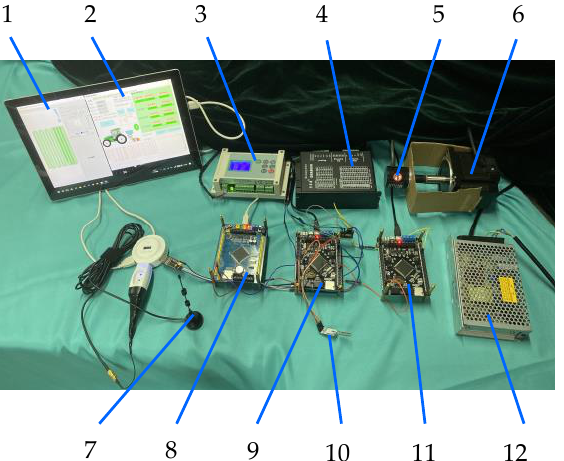
Figure 9. Bench test equipment. Components: 1. AG Leader Technology GPS Simulator simulation software. 2. Monitoring software. 3. Stepper motor controller. 4. Stepper motor driver. 5. Encoder. 6. Stepper motor. 7. Data communication antenna. 8. Seed signal simulation microcomputer. 9. Mon-